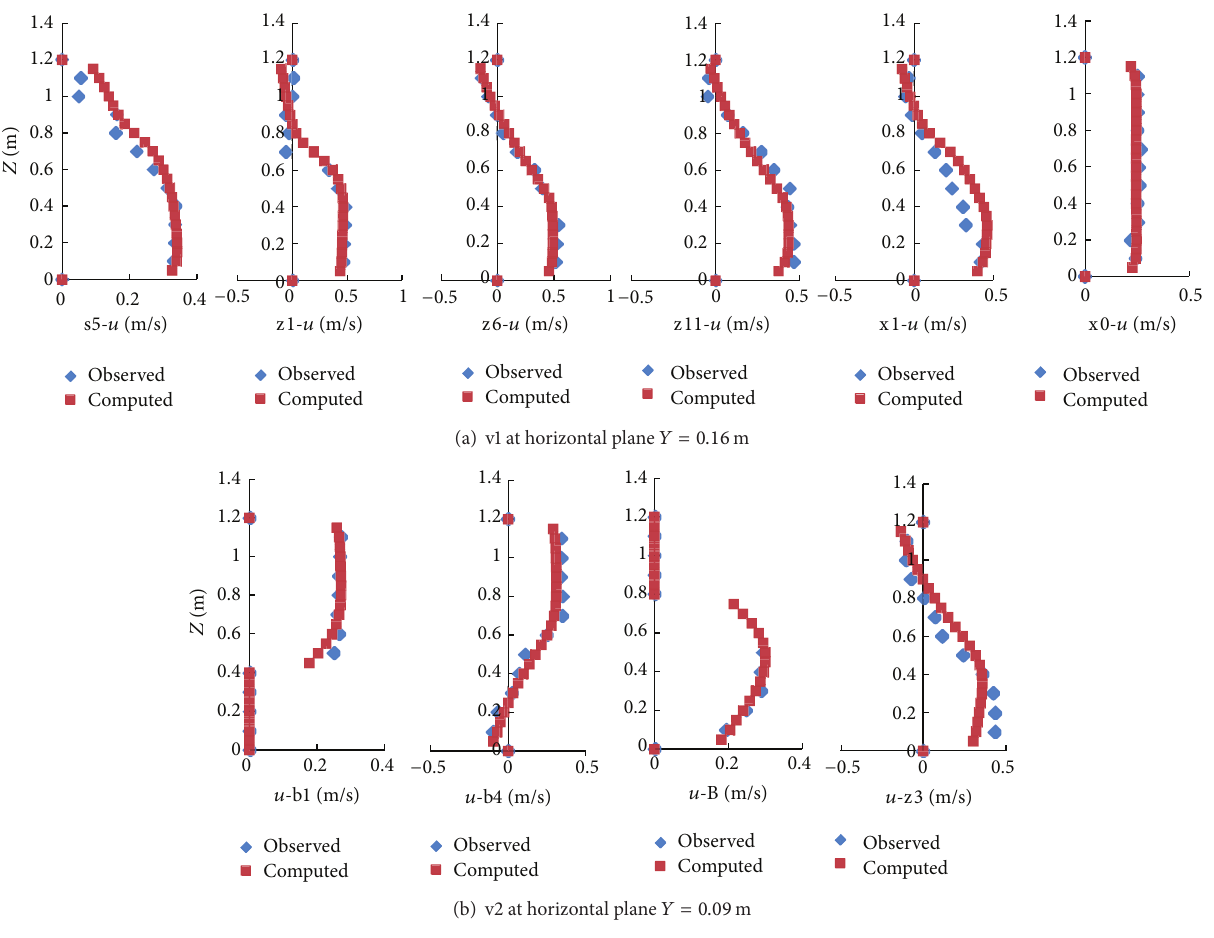
Figure 3: Comparison of 𝑢 between observed and computed values.